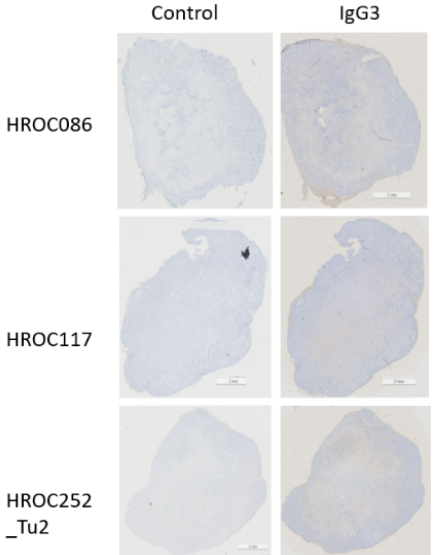
Figure 2. Immunolabelling of intracellular IgG3 in CRC samples. Examples of staining include single